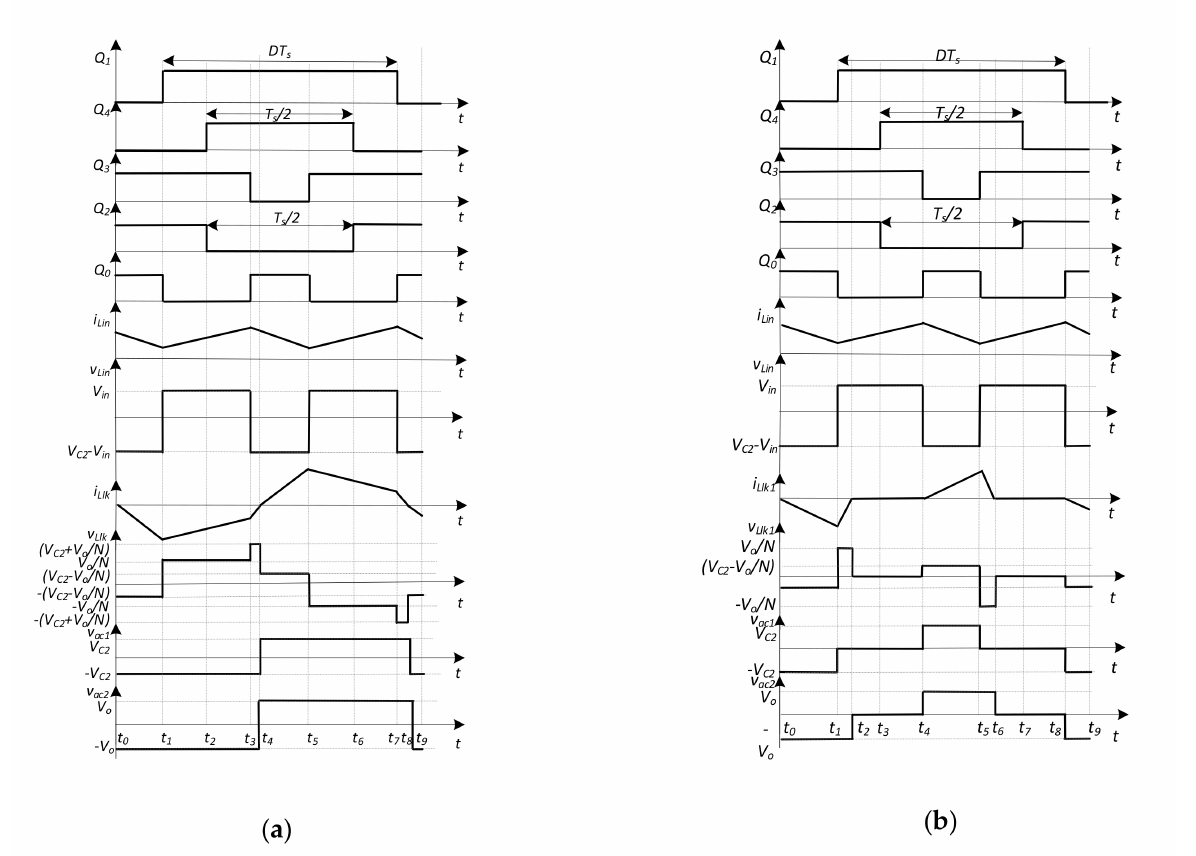
Figure 4. Switching sequence diagram of step-up mode. ( a ) Step-up-CCM1; ( b ) Step-up-CCM2.